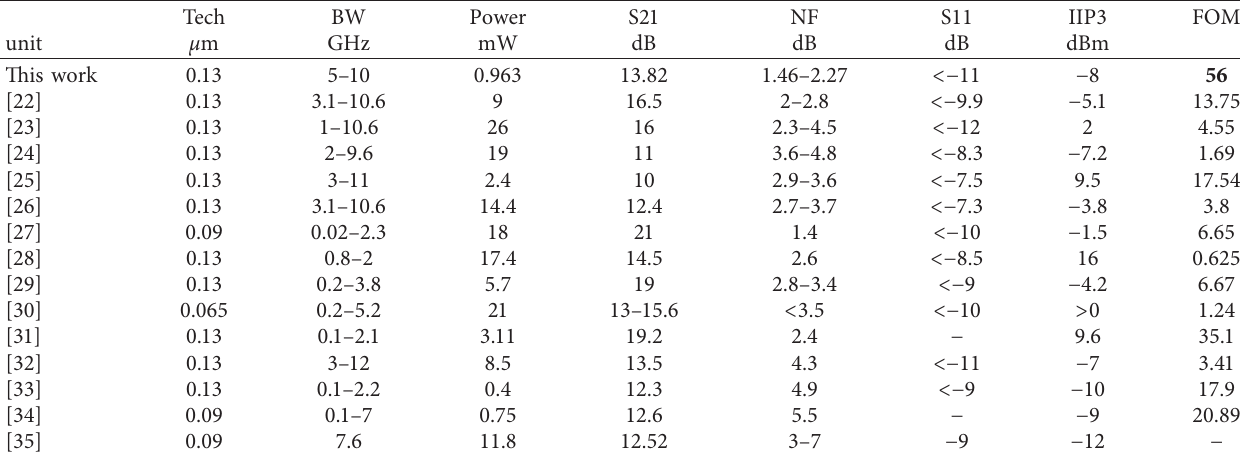
Figure 15: IIP3 at 7.5GHz. Table 1: Performance summary and comparison with other state-of-the-art